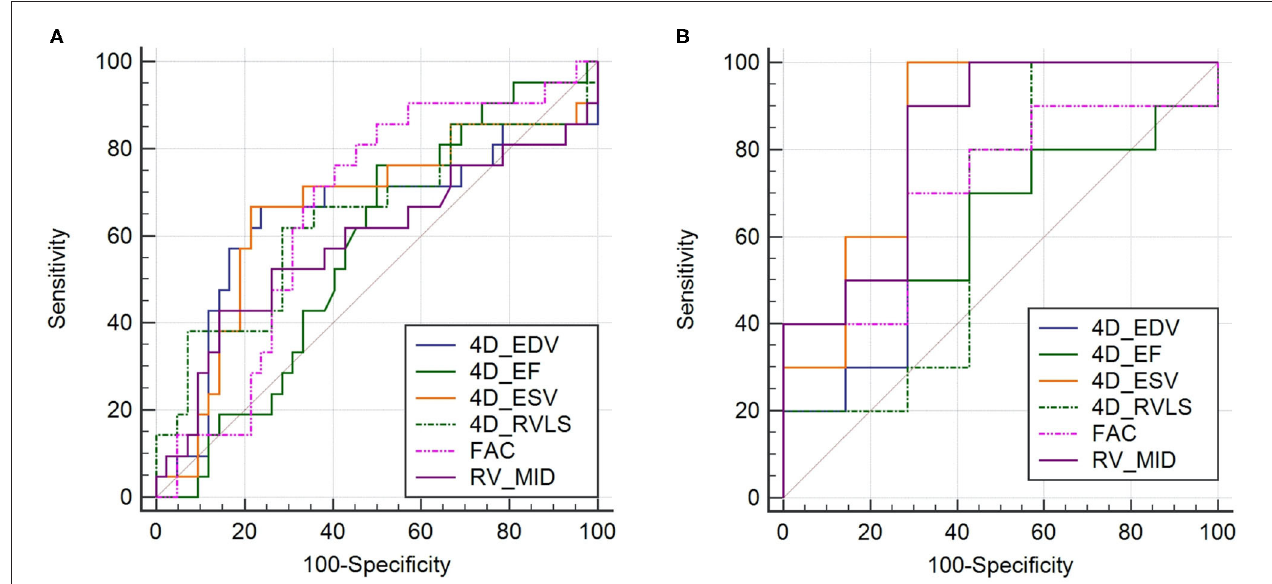
FIGURE 2 | Receiver operating characteristic curves in all patient groups of PHTN ( n = 76) of 4D auto-RVQ areas of (A) and in the high-quality image group of PHTN ( n = 24) (B) . 4D_EDV, four-dimensional end-diastolic volume; 4D_ESV, four-dimensional end-systolic volume; 4D_EF, four-dimensional ejection fraction; 4D-RVLS, right ventricular longitudinal strain of the free wall; FAC, fractional area change; RV_MID, mid–right ventricular diameter.